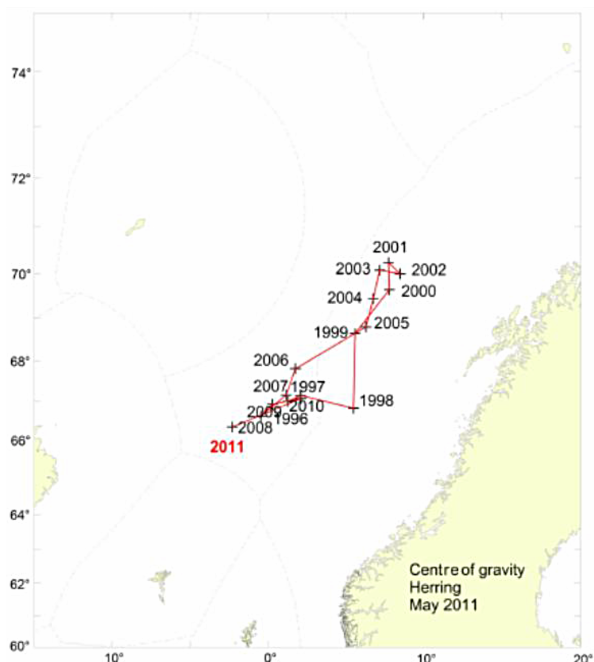
Figure 5. Centre of gravity of Norwegian spring-spawning (NSS) herring during the period 1996–2011 derived from acoustic